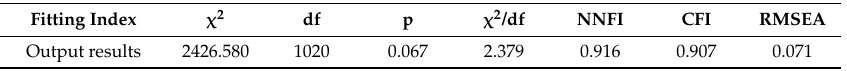
Table 5. Confirmatory factor analysis model fitting index